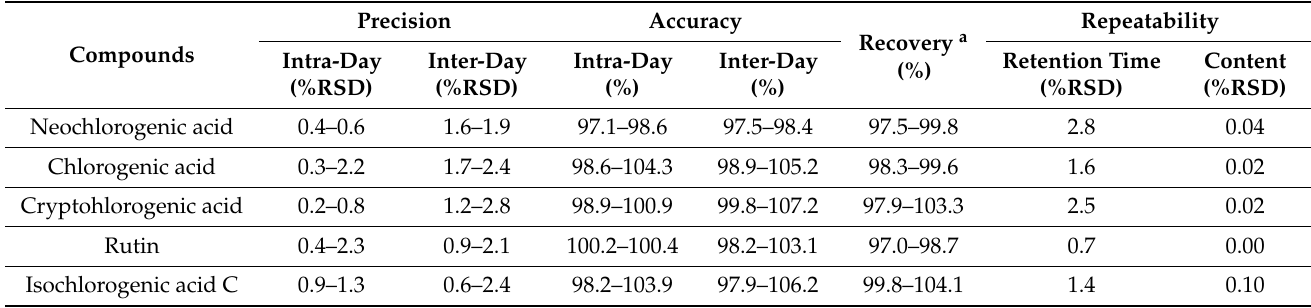
Table 2. Precision, accuracy, recovery and repeatability of the investigated